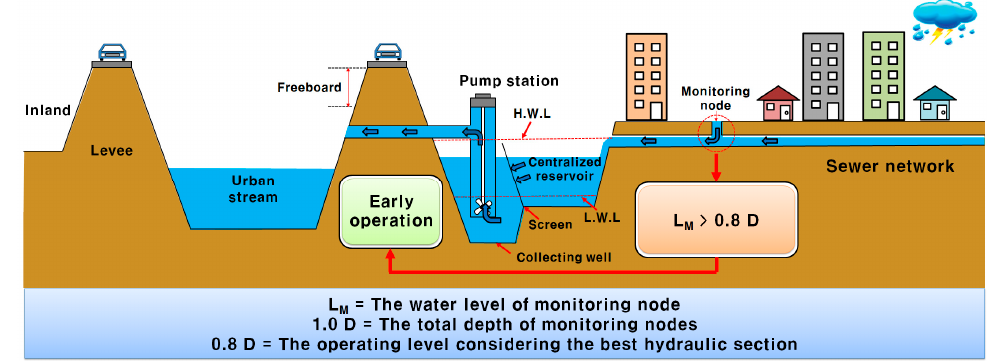
Figure 4. Pump operation of centralized reservoirs in pump stations.